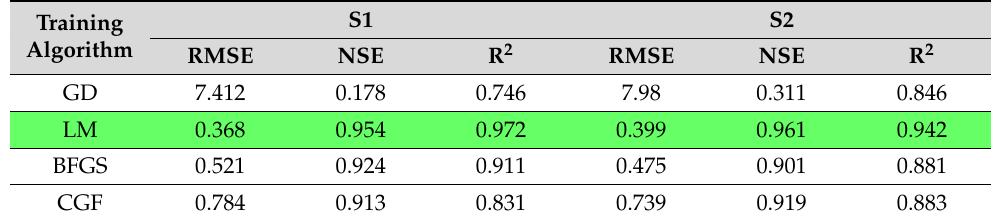
Table 2. Statistical indicators related to the use of various training functions for S1 and S2.